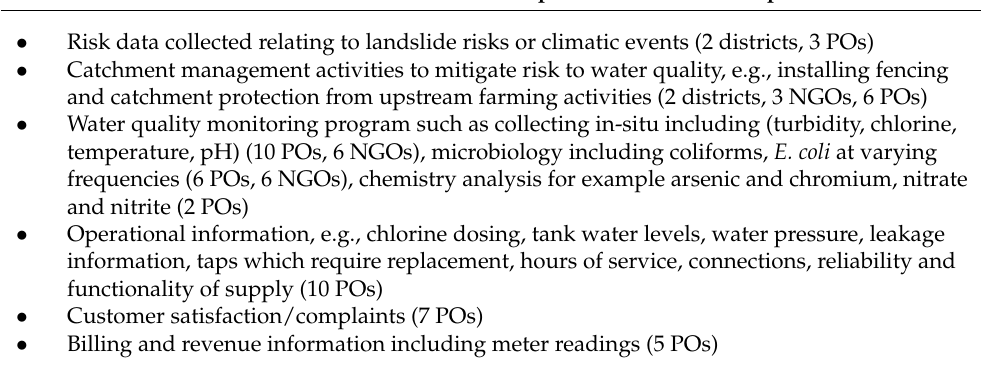
Table 2. Current data and information collected by the different stakeholder groups which could be used to feed into a WSP. PO—private operator, NGO—non-governmental